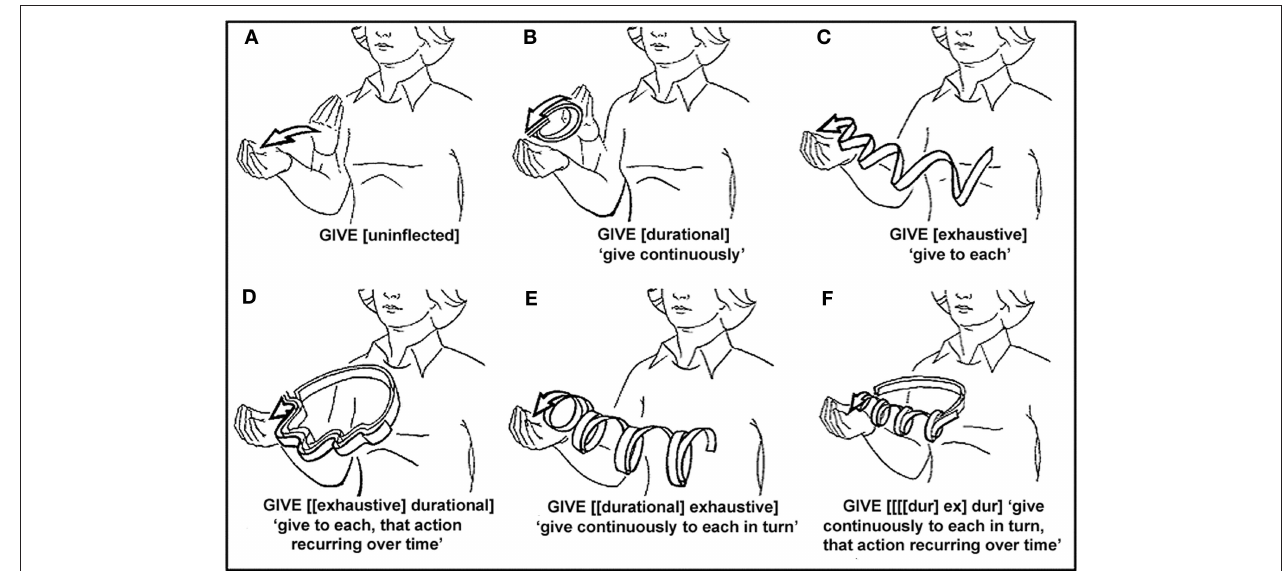
FigurE 2 | different forms of iconically-motivated aSL aspectual morphemes (durational, continual and exhaustive) both singly (B, c) and in combination (d– F) . Picture (a) indicates the uninflected form. Reprinted with permission from Poizner et al. (1987).